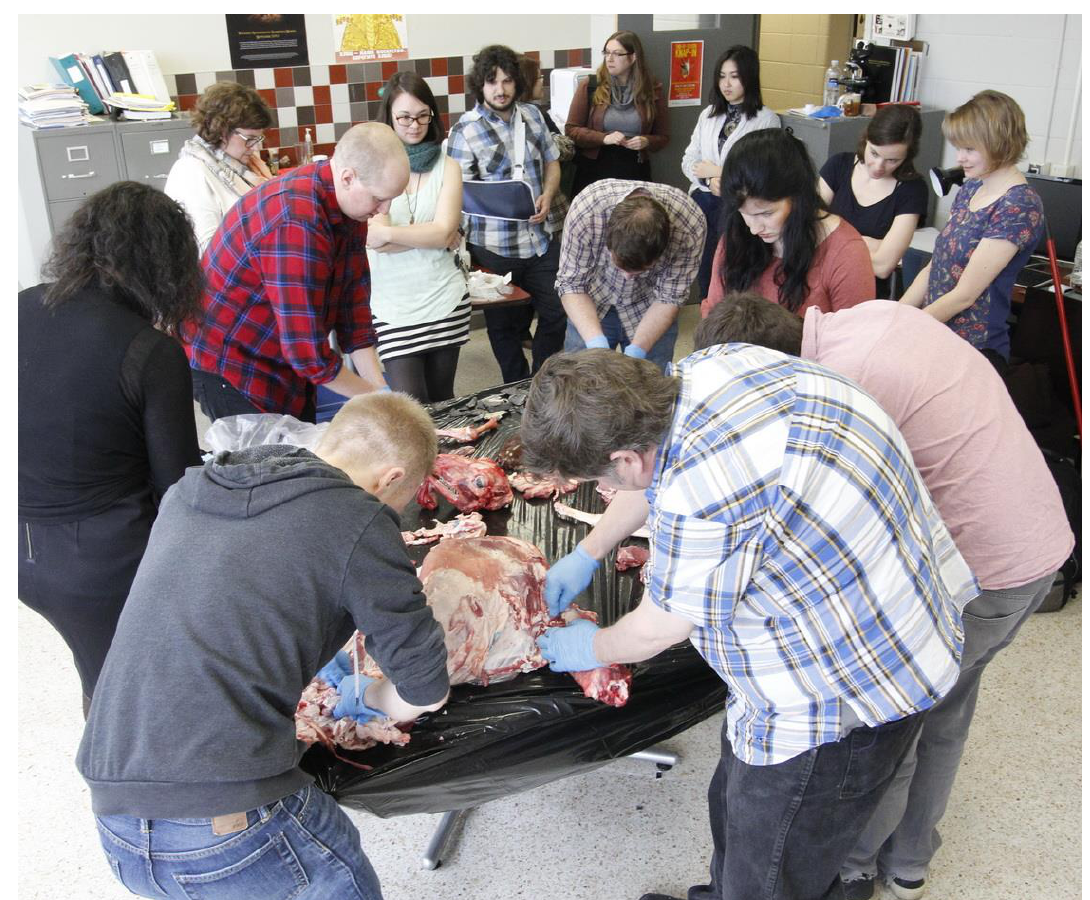
Figure 4. Participants butcher the sheep as colleagues observe the